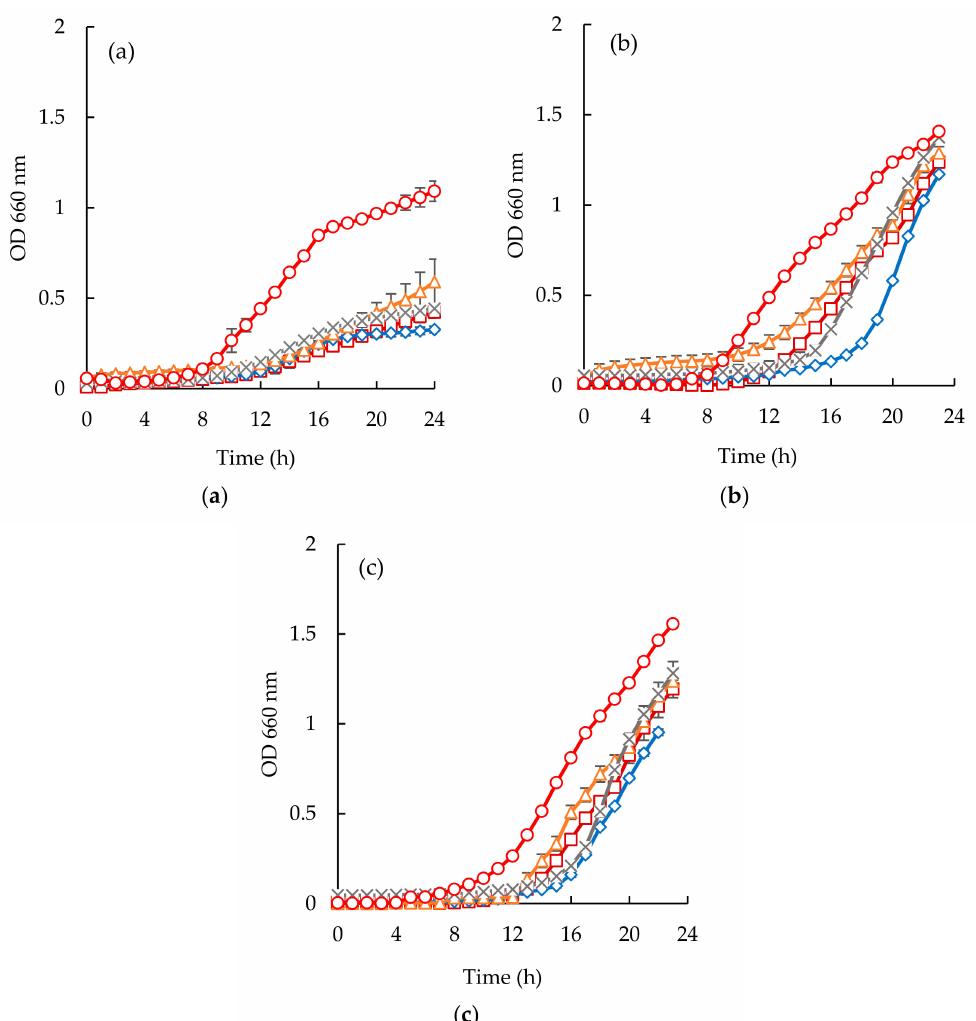
Figure 6. Time inhibition curves drawn at di ff erent permeates obtained from codfish blood ( control; (cid:3) , codfish blood; x, GE Suez MW; ∆ , GE Suez PW; ♦ , Microdyn Nadir UP010 for E. coli ( a ), S. aureus ( b ), C. albicans ( c